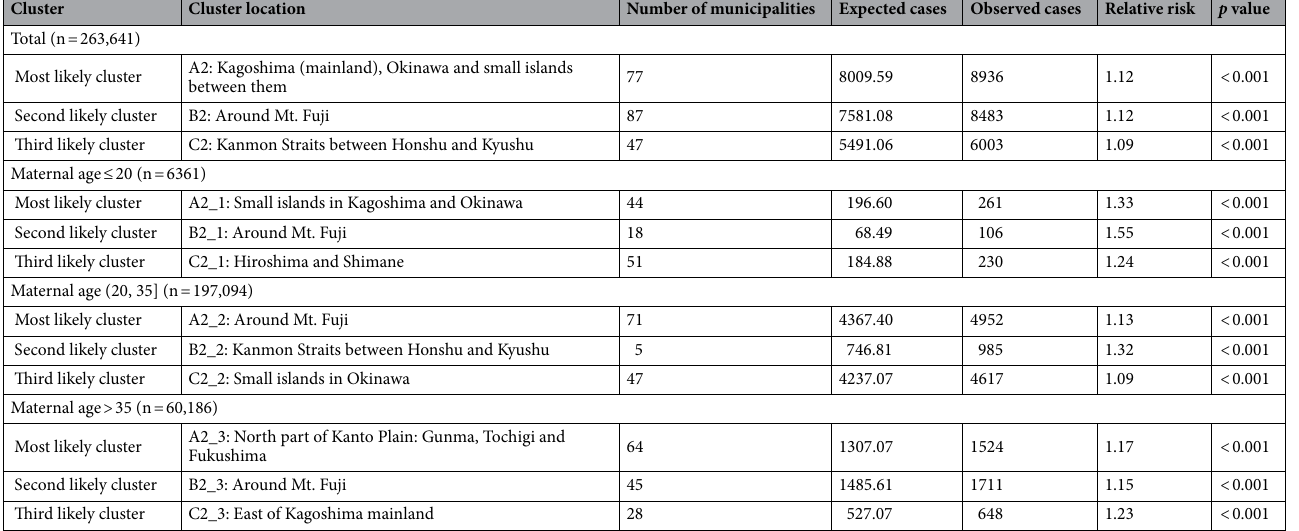
Table 3. Geographical clusters of LBWterm in